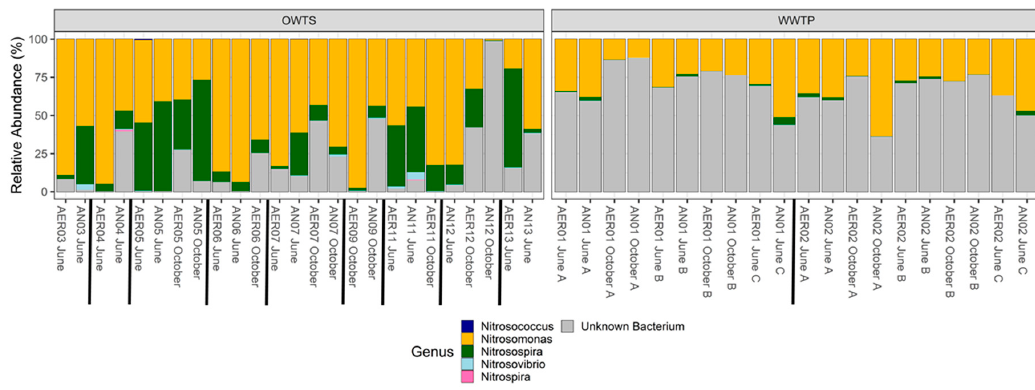
Figure 3. Relative abundance of amoA in a biological nitrogen removal (BNR) wastewater treatment plant (WTP) and in advanced N-removal onsite wastewater treatment systems (OWTS). Labels indicate zone (AER = oxic; AN = hypoxic / anoxic), system number, month sampled, and replicate letter (A, B, C; WTP only). WTP = systems 01 and 02; OWTS = systems 03 to